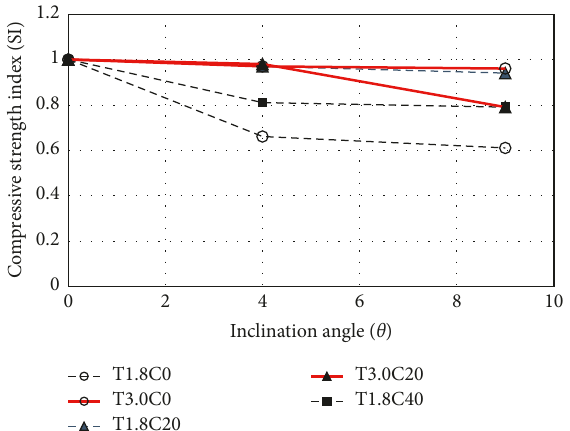
Figure 5: Compressive strength index due to inclination angle.